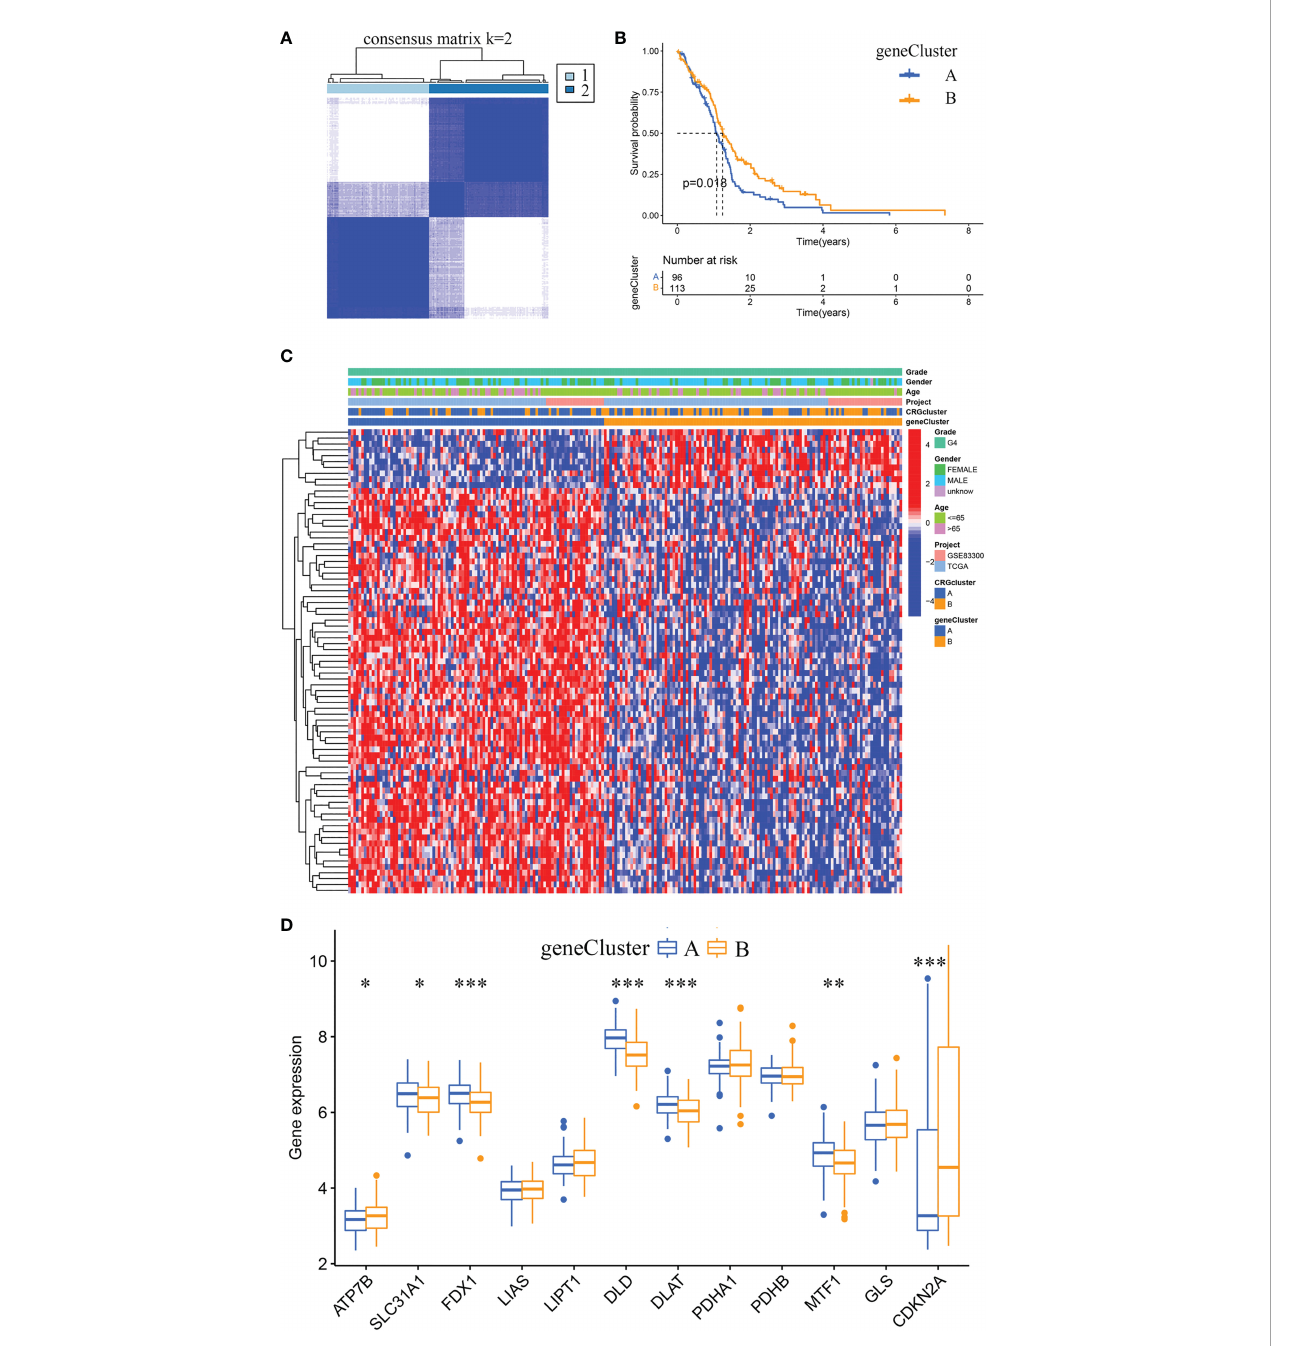
FIGURE 5 Identi fi cation of gene subtypes and comparison of clinical characteristics and CRGs expression levels between the two gene subtypes. (A) Unsupervised clustering analysis of prognostic DEGs between the two cuproptosis subtypes. Consensus matrix heatmap de fi ning two clusters (k = 2) and their correlation area. (B) Kaplan-Meier curves for OS of the two gene subtypes (chi-square test, p = 0.018). (C) The heat map shows the differences in clinical features, and prognostic DEGs expression levels between geneCluster A and geneCluster B. (D) Box plot shows the differences of CRGs expression levels between geneCluster A and geneCluster B. DEGs, differentially expressed genes; CRGs, cuproptosis-related genes. * p < 0.05, ** p < 0.01, *** p < 0.001 vs. geneCluster